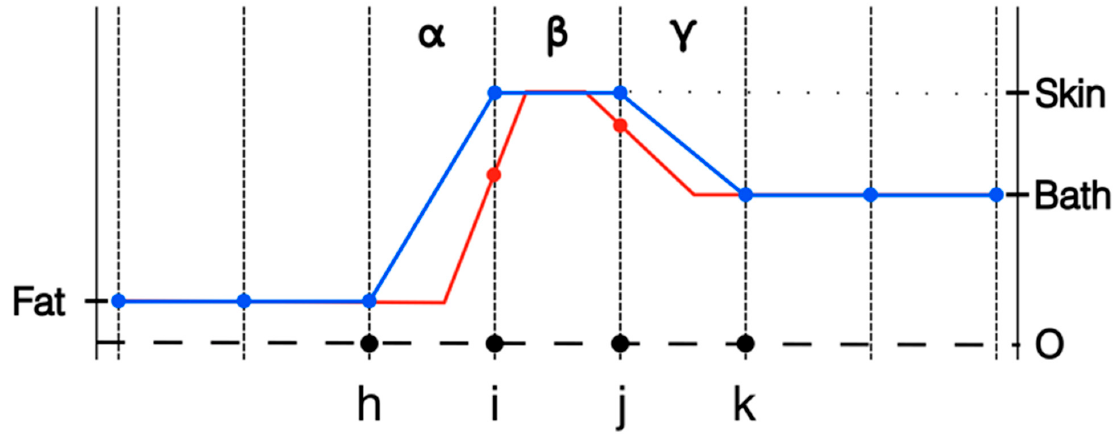
Figure 2. 1D representations of the transecting property distributions from fat to skin to coupling bath using nodal representation: full element width, and half element width, respectively.